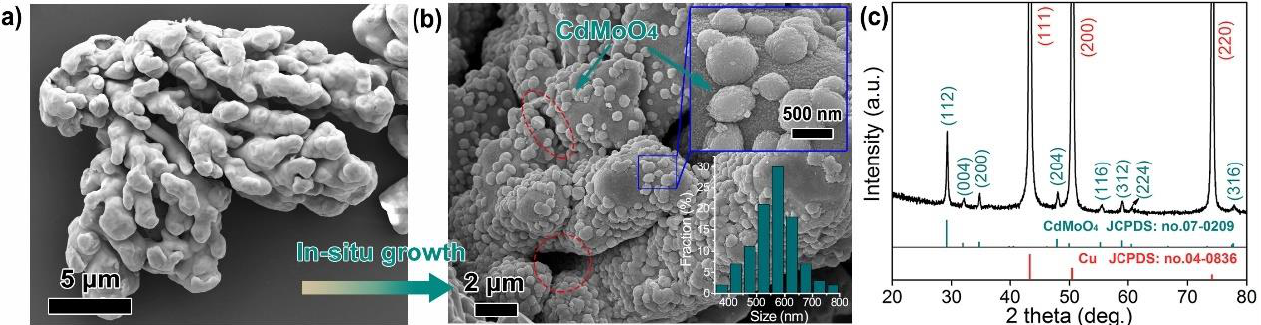
Figure 2. SEM images of ( a ) raw Cu powders and ( b ) as-synthesized CdMoO 4 /Cu mixed powders. ( c ) XRD pattern of the CdMoO 4 /Cu mixed powders. The inset in ( b ) is the high-magnification SEM image of CdMoO 4 /Cu mixed powders and corresponding size distribution diagrams for CdMoO 4 particles.